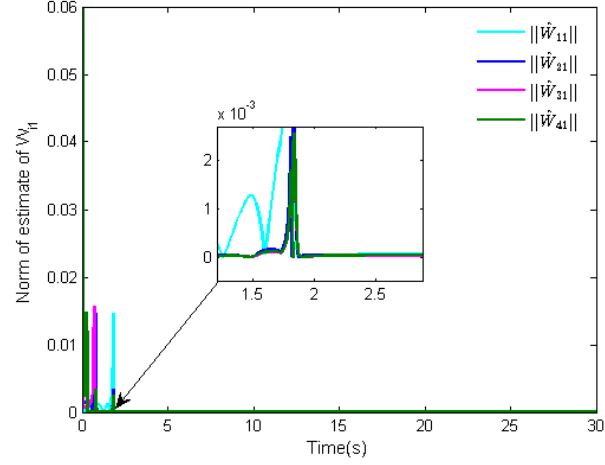
Figure 8. The curves of the norm for the adaptive control law ˆ W i 1 .